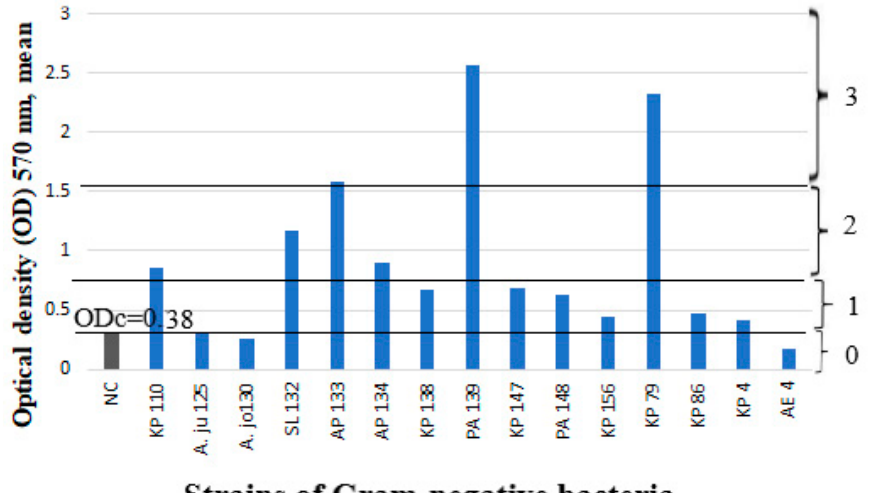
Figure 2. Biofilm production capability on microtiter plates of 15 strains of Gram-negative bacteria. Bars represent mean values of OD (measured at wavelength of 570 nm). Luria–Bertani medium as a negative control (NC). The number designates the participant; the letters indicate the strain iso-